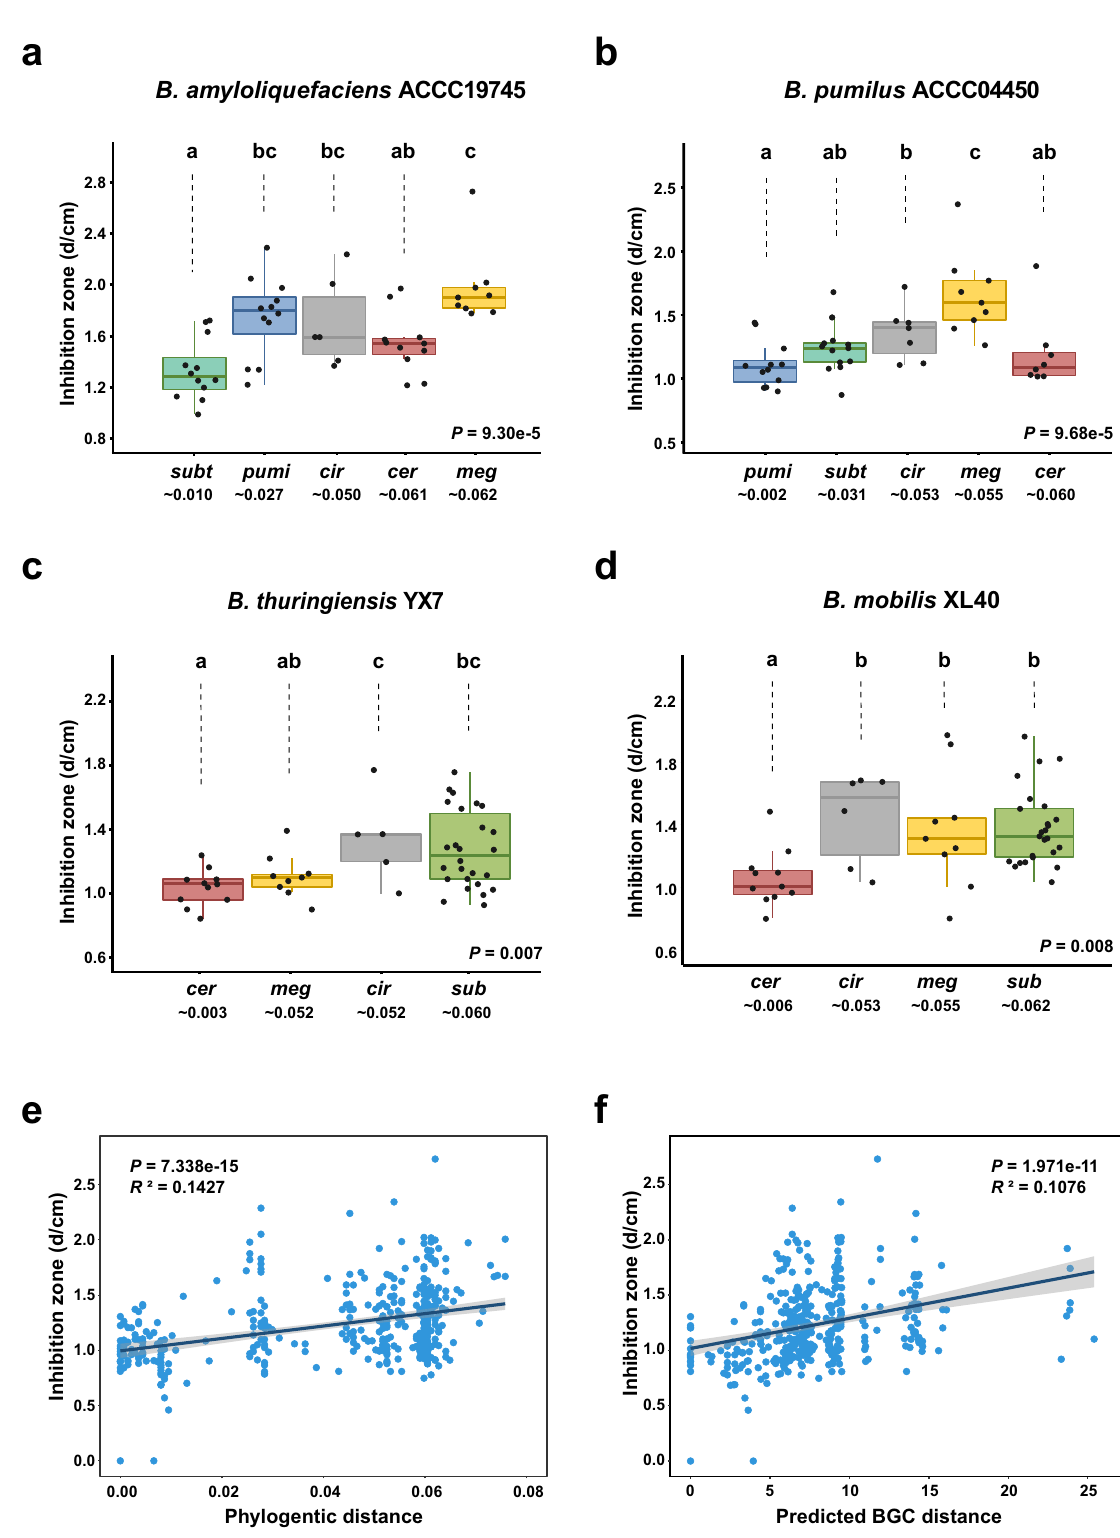
diverse Gram-positive bacteria 30 . As expected, antagonism showed a signi fi cant positive correlation with both phylogenetic (Fig. 4b, P < 2.2 × 10 − 16 , R 2 = 0.1618) and predicted BGC distance (Fig. 4c, P = 2.241 × 10 − 13 , R 2 = 0.08523); while within clades, this signi fi cant concordance between inhibition and phylogram was recovered in the subtilis clade but not